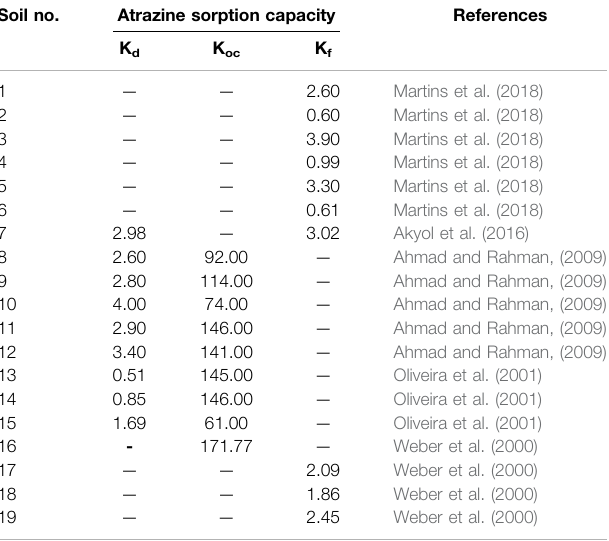
TABLE 4 | Sorption capacity of atrazine from previous studies. Soil